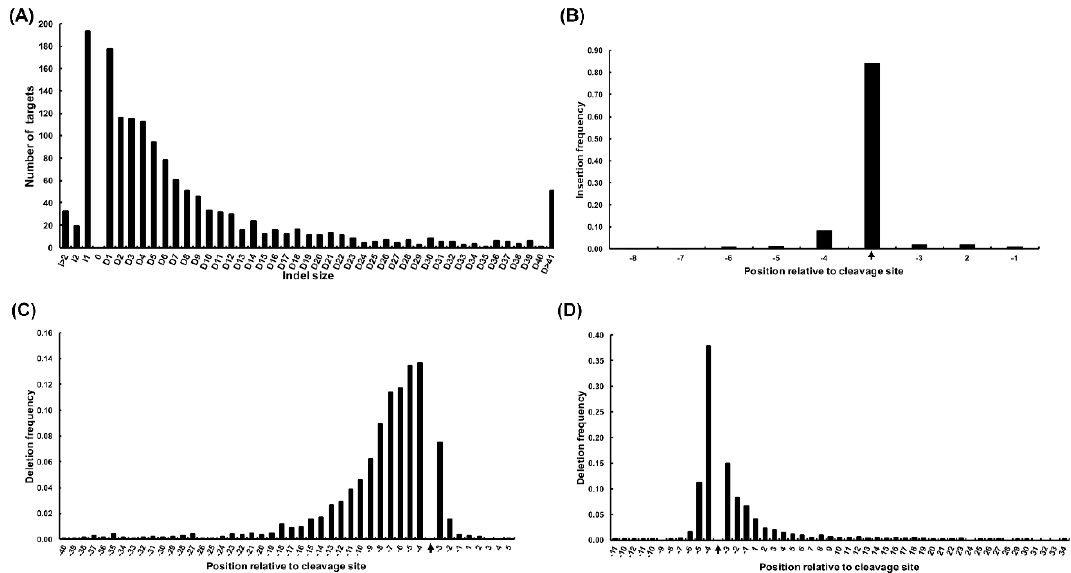
Figure 1. Summary of on-target variations in multiple plants subjected to clustered regularly interspaced short palindromic repeats (CRISPR) / CRISPR-associated protein (Cas9)-mediated editing. ( A ) Distribution of the most common indel size at on-target sites. ‘D’ represents deletion and ‘I’ represents insertion. ( B ) Distribution of the insertion sites of the targets. ‘ − 1’ on the X -axis represents 1 nt upstream of the protospacer adjacent motif (PAM), and black arrows represent cleavage sites. ( C ) Distribution of the starting sites of deletions at target sites. ( D ) Distribution of the ending sites of deletions at target sites.